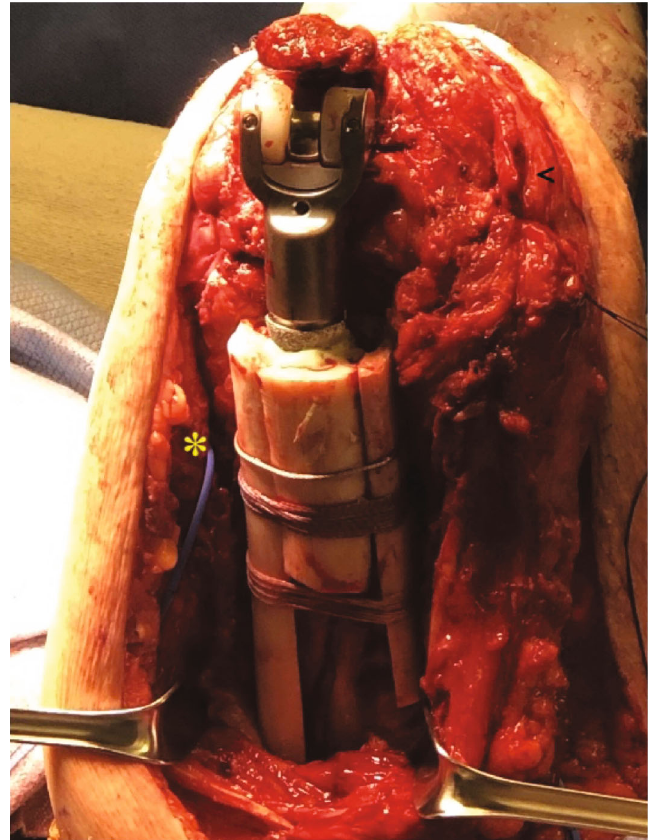
Figure 4: Intraoperative images showing a “ sandwich ” technique of the femoral strut allograft and total elbow arthroplasty with 50 mm distal augment. Triceps tendon (black < ) released o ff the ulna in a continuous sleeve with anconeus muscle. Ulnar nerve (yellow ∗ ) marked with a vessel loop to ensure protection throughout the